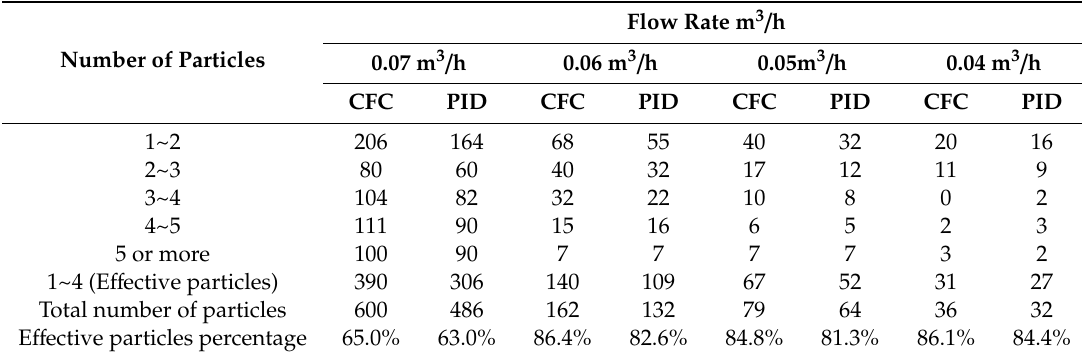
Table 7. Spray conditions at various flow rates at the pressure of app. 0.2 MPa.